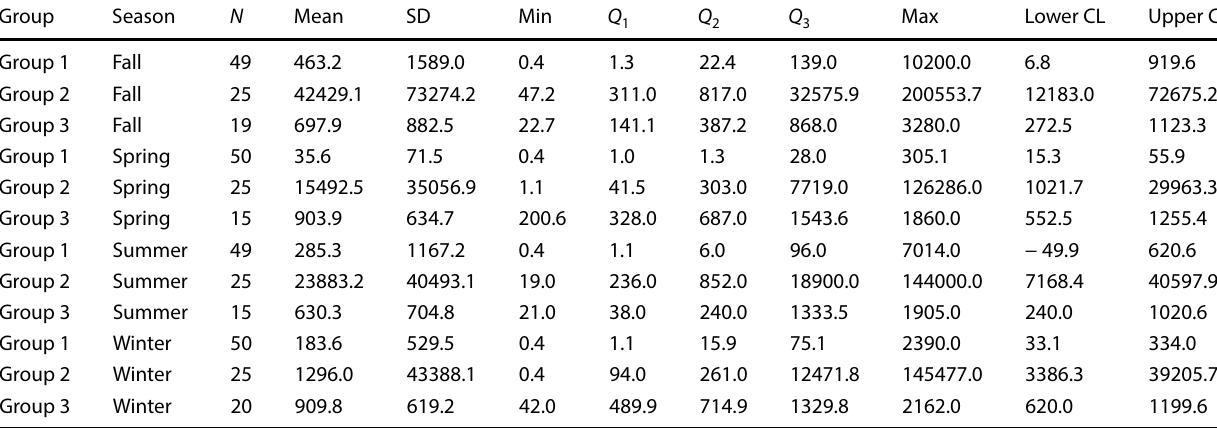
Table 4 The descriptive statistics of the removal of compounds for groups across seasons